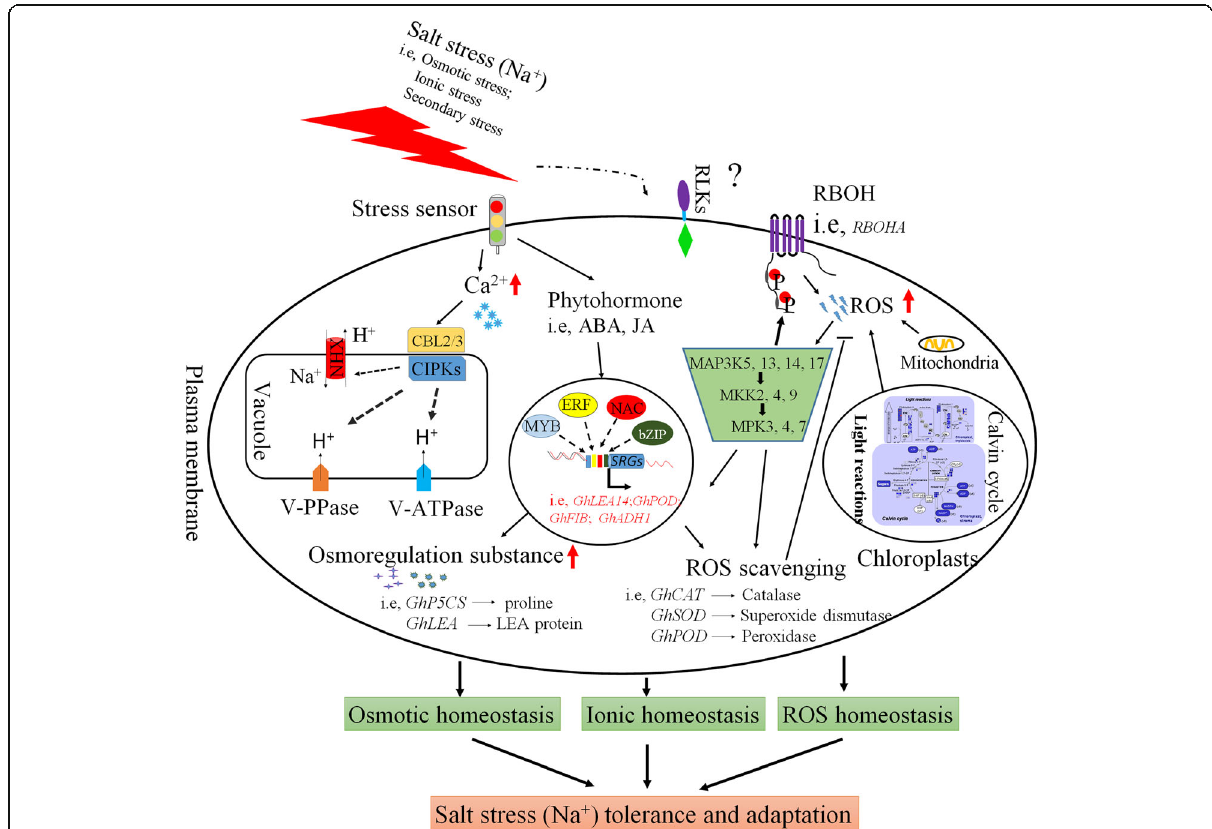
Fig. 6 Schematic presentation of a possible regulatory model in cotton ( Gossypium hirsutum L. acc. Xinluzhong 54) leaves under salt stress. Cells of cotton sense salt stress by RLKs or other unknown sensors, then transfer the external signal to the cytoplasm, and change the content of Ca 2+